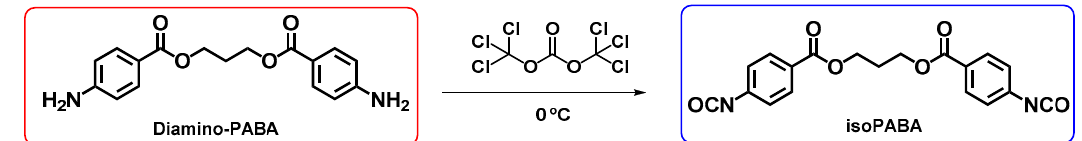
Figure 1. Comparison of 1H-NMR spectra in CDCl 3 of diamino-PABA (in black) and isoPABA prod- ucts (in red).